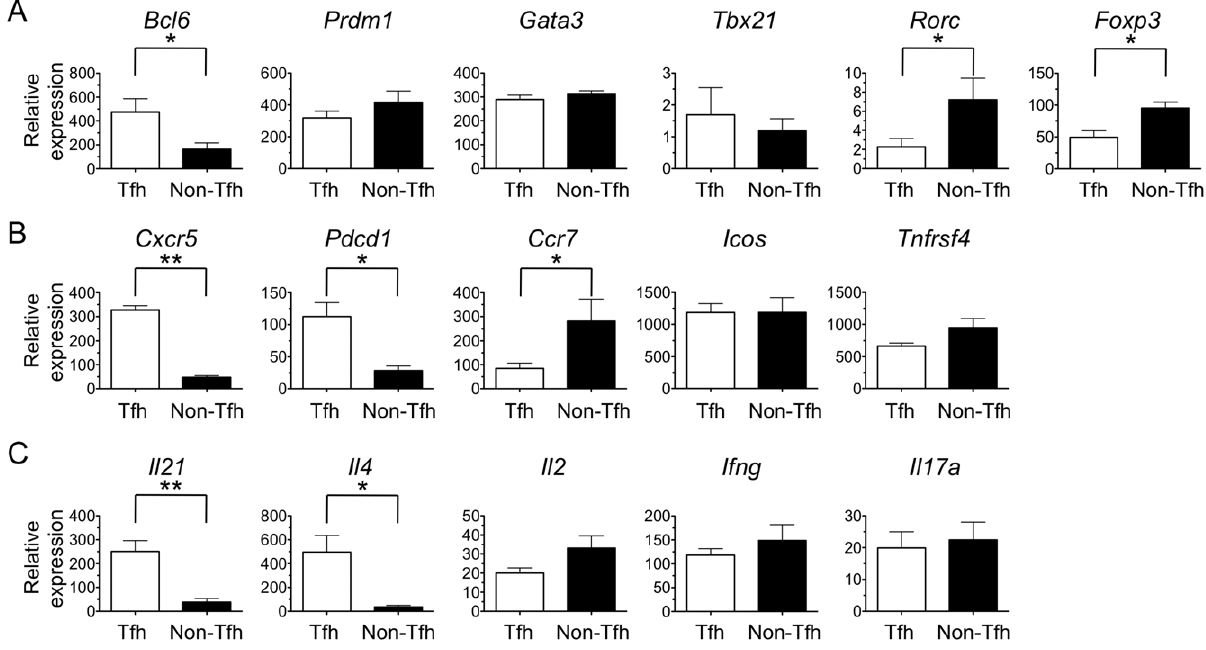
Figure 3. Sorted CD4 + CD44 high CXCR5 high PD1 high cells express a transcriptional profile that is consistent with the Tfh phenotype. Real-time PCR analyses of cDNA synthesized from total RNA extracted from sorted Tfh and non-Tfh cells (as depicted in Fig. 2) and analyzed for expression of mRNA encoding transcription factors (A), chemokine receptors or accessory molecules (B), or cytokines (C). Expression data is normalized to the average expression of Bact, Gapdh, B2m . The means of four experiments are shown, with error bars indicating the standard error of the mean (S.E.M). Data were analyzed with unpaired two-tailed student T-test, and * indicates a p-value of less than 0.1, while ** indicates a p-value of less than 0.001. doi:10.1371/journal.pone.0046952.g003 PLOS ONE |